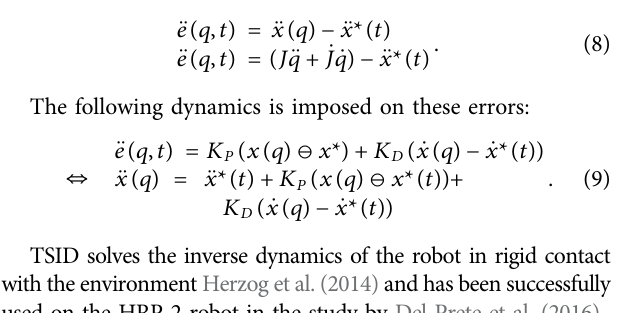
Figure 2 . Compared to the previous controller, this one implements an AM task, which regulates the angular have implemented this controller using TSID Del Prete (2021) library in the same package than the controller TSID Torque with the DCM and CoM admittance controllers.